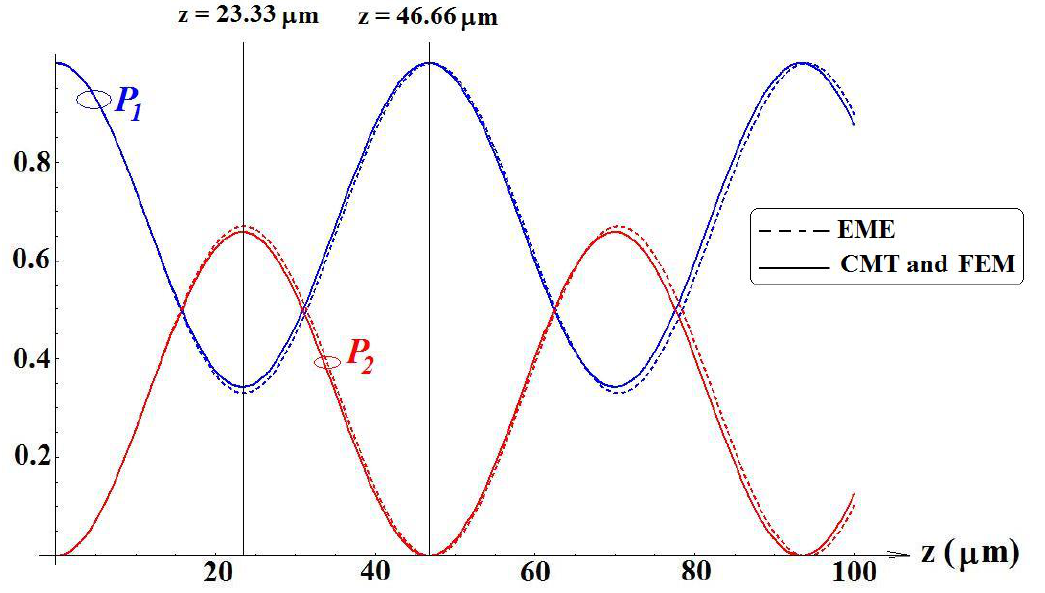
Figure 7 . Normalized optical power confined in the two coupled waveguides (with d = 1 μ m) versus propagation length for quasi-TE mode (Solid curves: modelling technique of this paper based on CMT and FEM; Dashed curves: results by 3D EME